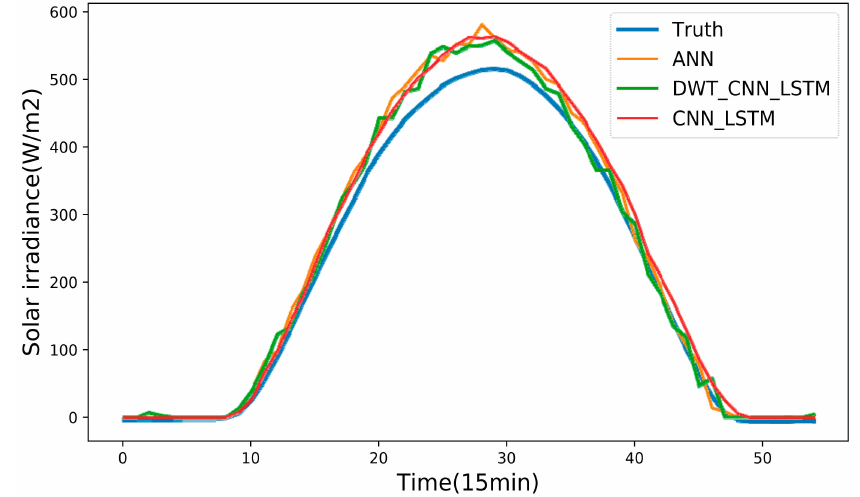
Figure 7. Actual and forecasted solar irradiance on sunny day pattern using dataset of Elizabeth City State University.